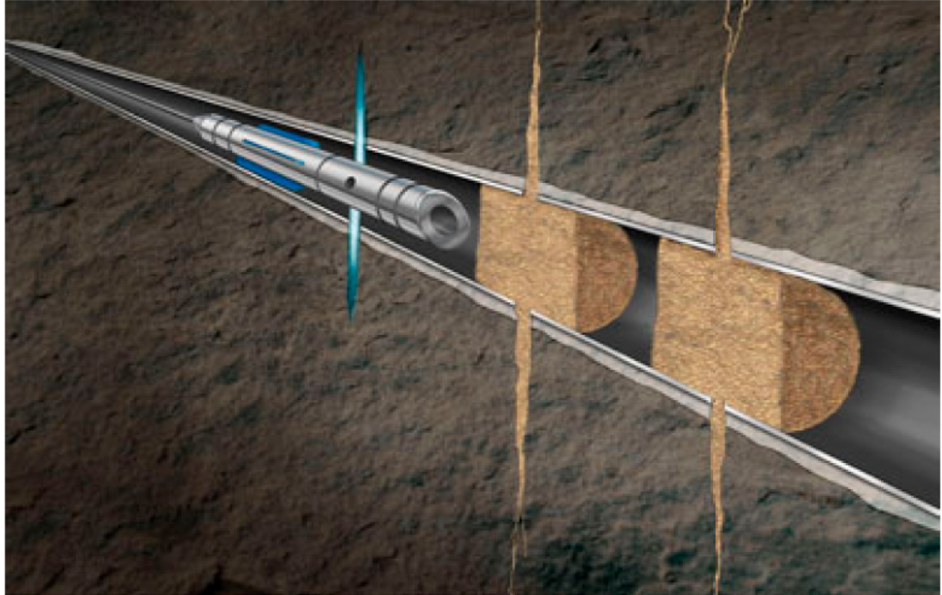
Figure 4. Schematic diagram of hydraulic jet fracturing.